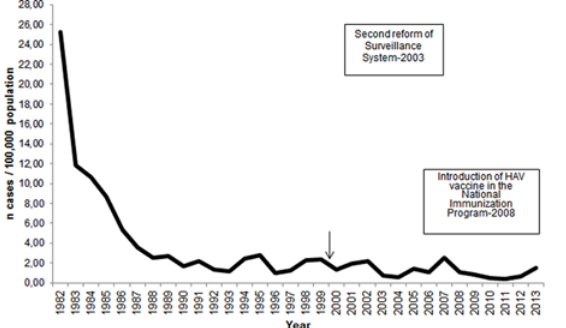
Figure 1. Yearly distribution of hepatitis A notification rate (cases per 100,000 population), Mandatory Notification System, Greece, 1982 – 2013.